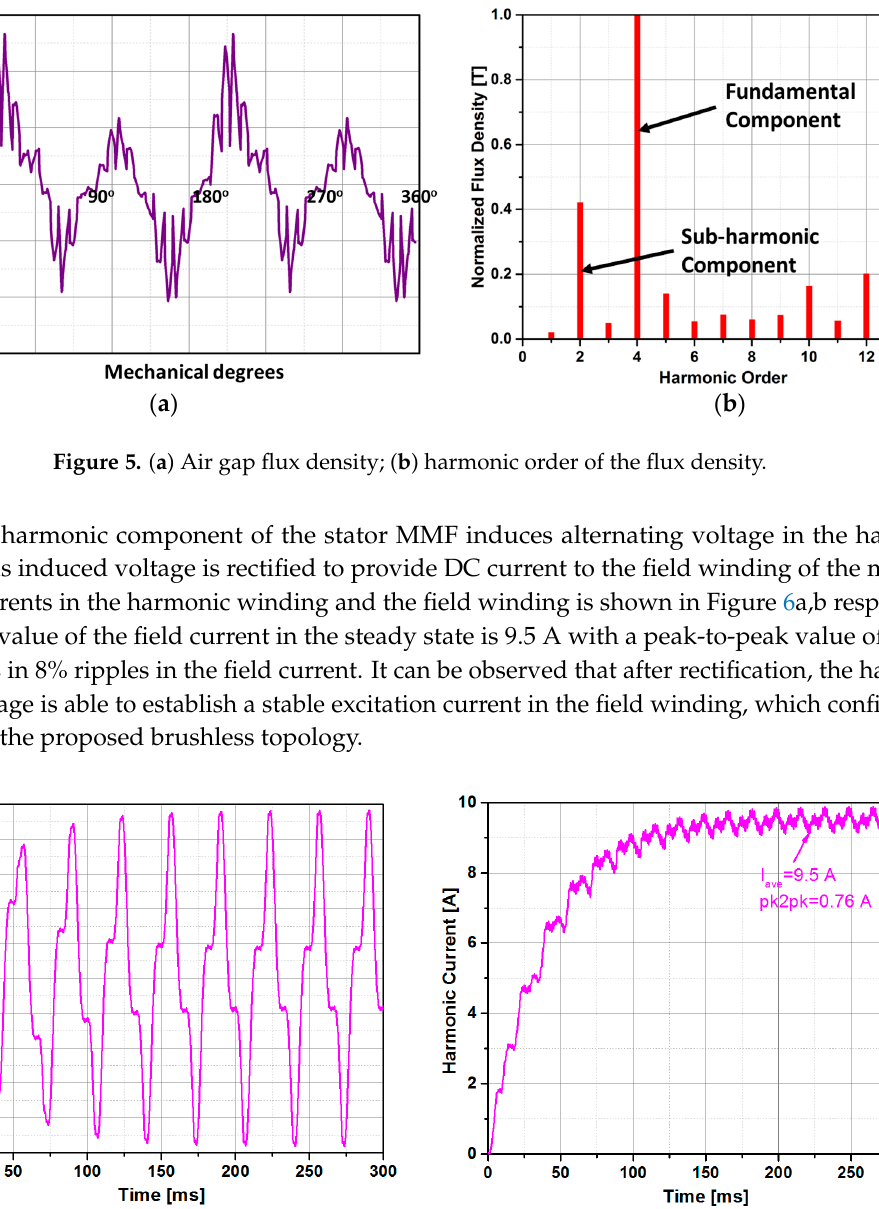
Figure 7. Torque of the BL ‐ WRSM (basic model). 3.2. Rotor Pole Shape Optimization The pole shape in the salient pole machines is the most crucial factor, which affects the torque characteristics of the machine [21,22]. Therefore, the rotor pole span and the pole shoe height are